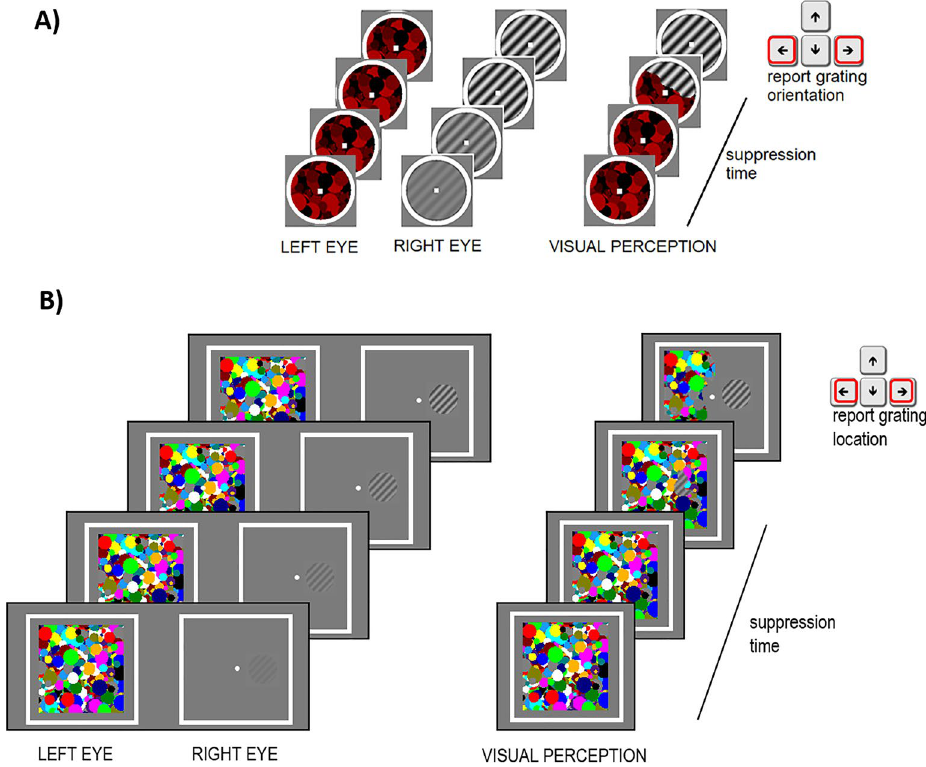
Figure 1. Breaking continuous flash suppression (b-CFS) experimental paradigm. ( A ) breaking Continuous Flash Suppression (b-CFS) task in Experiment 1. Observers reported the orientation of the grating using the appropriate keyboard keys as soon as it emerged from interocular suppression induced by a dynamic Mondrian patterns flashed in the other eye at 10 Hz. ( B ) b-CFS task in Experiment 2. Observers reported the location of the grating as soon as it emerged from interocular